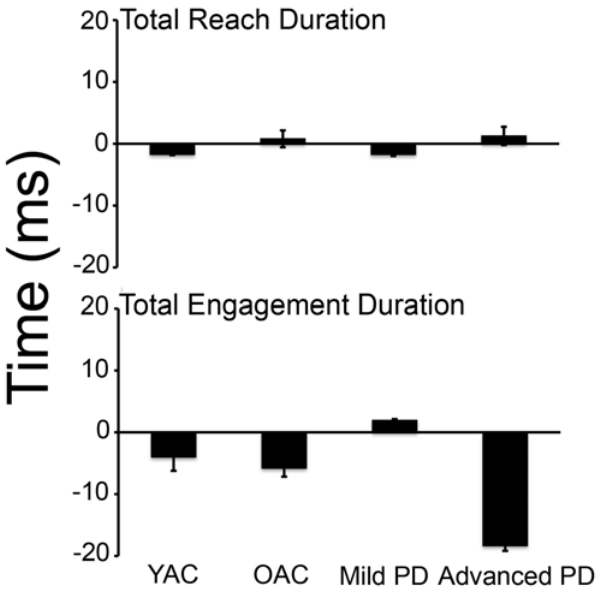
Figure 12. Reach duration (top) and engagement duration (bottom) difference for all experimental groups (no music- music); mean and standard errors. Note that the time to complete total reach duration was not affected by accompanying music, whereas time to complete total engagement duration was decreased for advanced PD